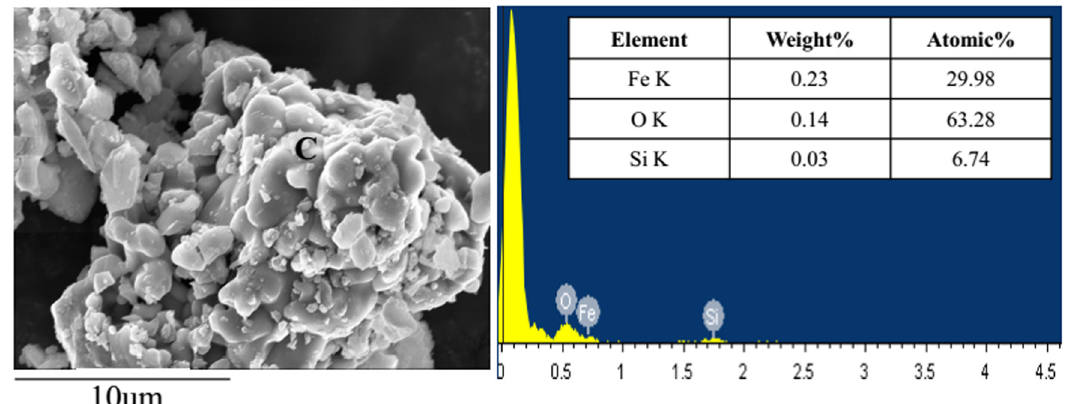
Figure 11: The SEM images and energy spectrum of C area in magnetic concentrate.